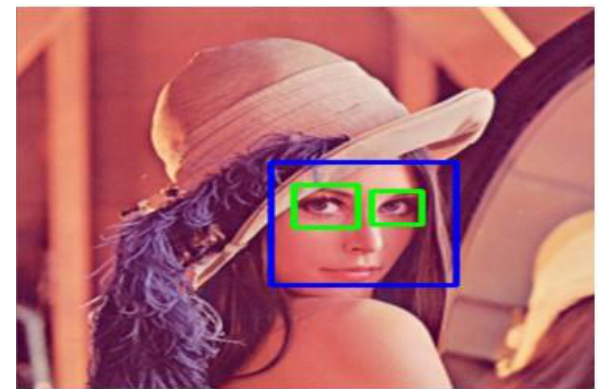
Figure 8. Successfully detect the face in an image.